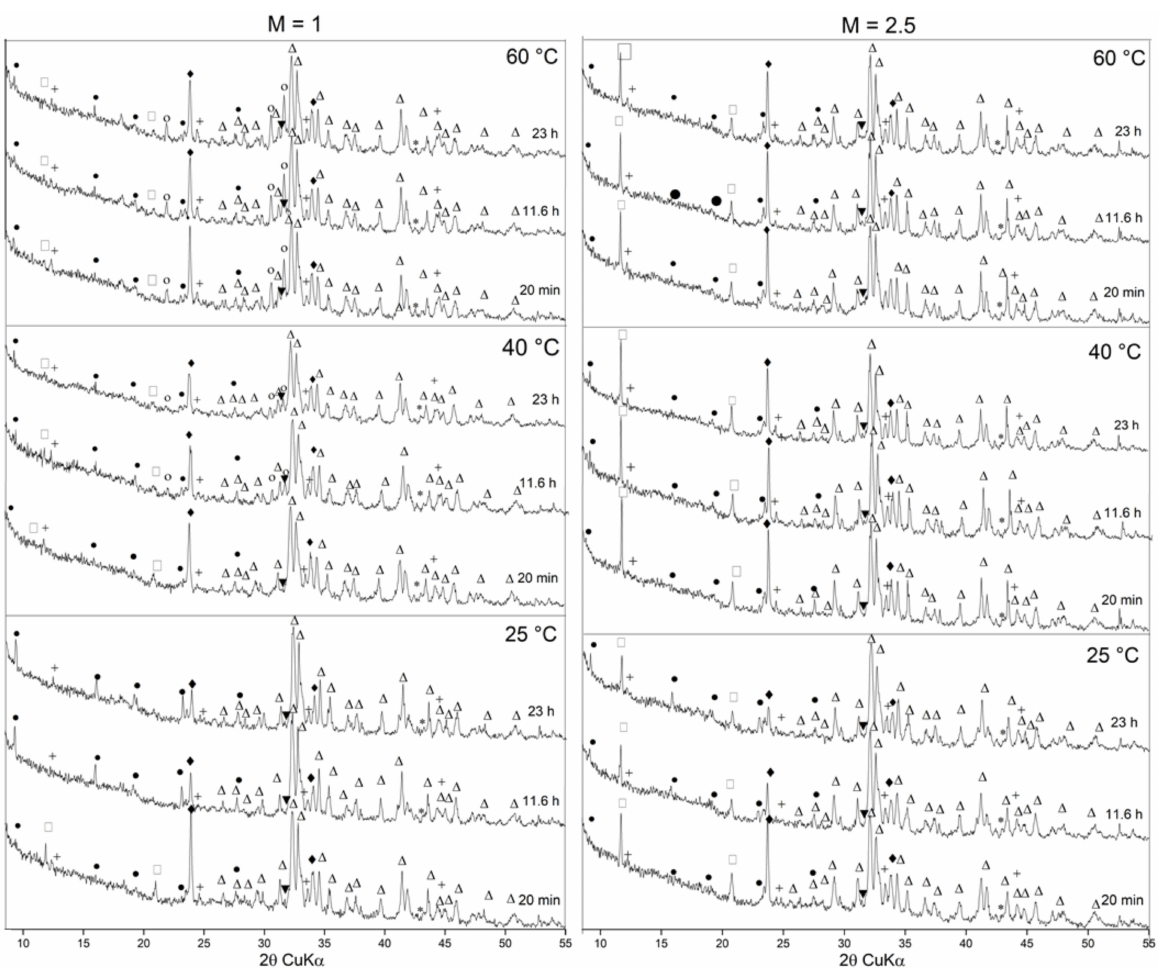
Figure 4. In situ X-ray powder diffraction patterns of the M = 1 and M = 2.5 samples at 25, 40 and 60 ◦ C after 20 min, 11.6 and 23 h in a selected 2 θ CuK α range. ∆ = belite, (cid:7) = calcium sulfoaluminate, + = ferrite, (cid:3) = gypsum, ∗ = periclase, (cid:72) = gehlenite, = aphthitalite, • = (cid:35)